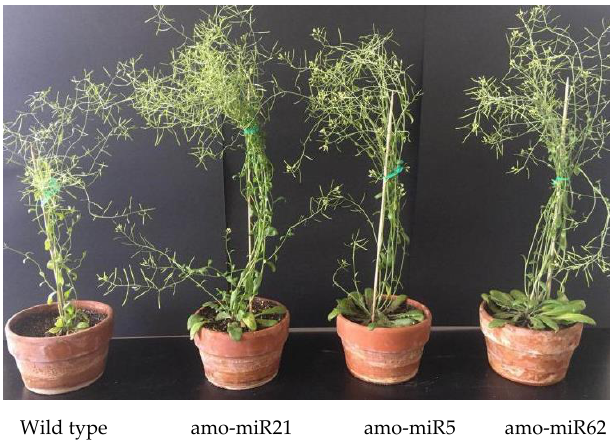
Figure 9. Phenotype of transgenic Arabidopsis lines under normal conditions at flowering stage.